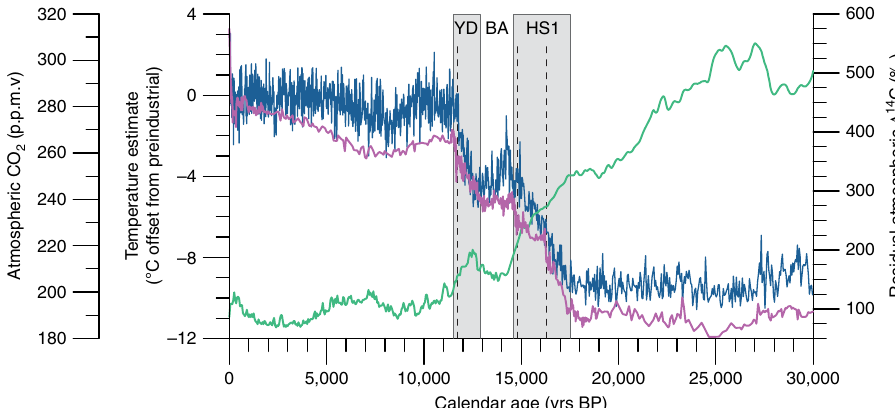
Figure 1 | Atmospheric CO 2 and temperature changes across the last deglaciation. Both atmospheric CO 2 from a composite record of Antarctic ice cores (blue) 65 and Antarctic temperature change recorded by the Epica Dome C ice core (pink) 3 show a two-step increase through the deglaciation. Increasing Atmospheric temperature and CO 2 during Heinrich Stadial 1 (HS1) and the Younger Dryas (YD) is separated by a period of little to no change during the BA. Atmospheric radiocarbon content ( D 14 C corrected for natural production; green) 6 decreases over the same period. Dashed lines indicate century-long periods of abrupt CO 2 rise identified by Marcott et al.